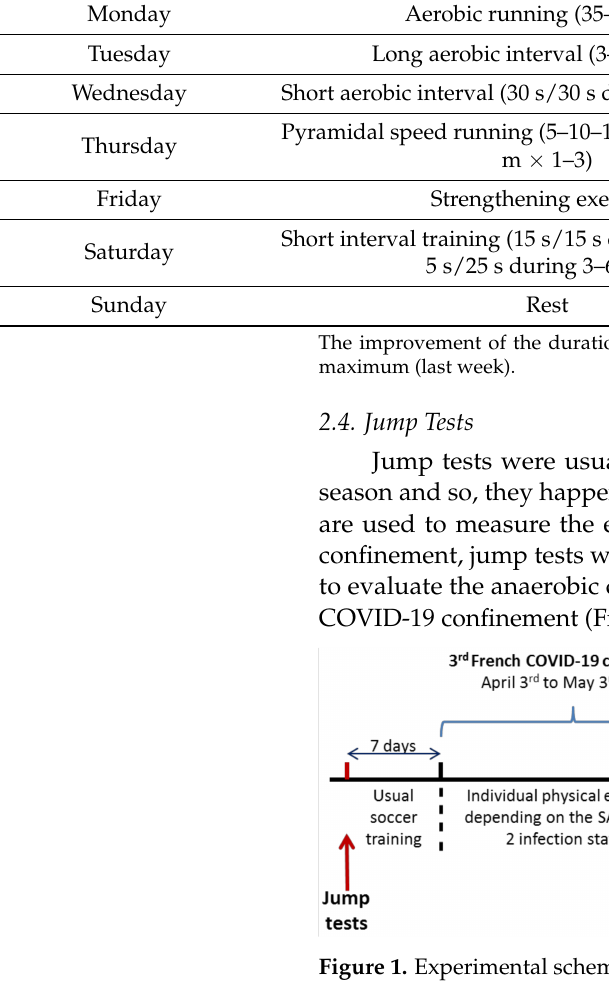
Table 1. Typical weeks of training during the 1-month COVID-19 confinement for the negative SARS-CoV-2 group and the 1-month retraining soccer period for the two groups. Exercises during COVID-19 Confinement for Soccer Retraining after COVID-19 Negative SARS-CoV-2 Group Confinement for the Two Groups